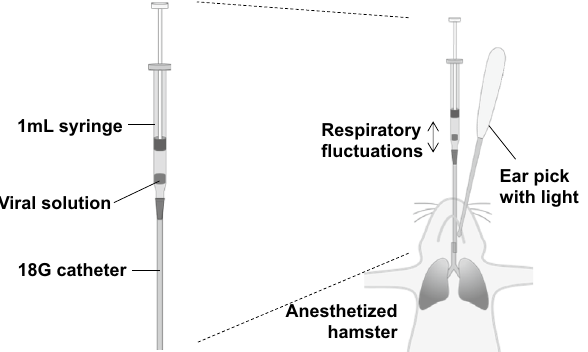
Figure 1. Schematic illustration of the inoculation of virus solution into the hamster airway. A viral solution (100 μL/hamster) with a small amount of air was prepared in a 1 mL syringe attached to an 18G catheter. After observing the glottis of the anesthetized hamster with an ear pick with light, the syringe set containing the viral solution was inserted through the oral cavity and advanced through the vocal cords. The respiratory fluctuations of the viral solution indicated that the tip of the catheter was in the